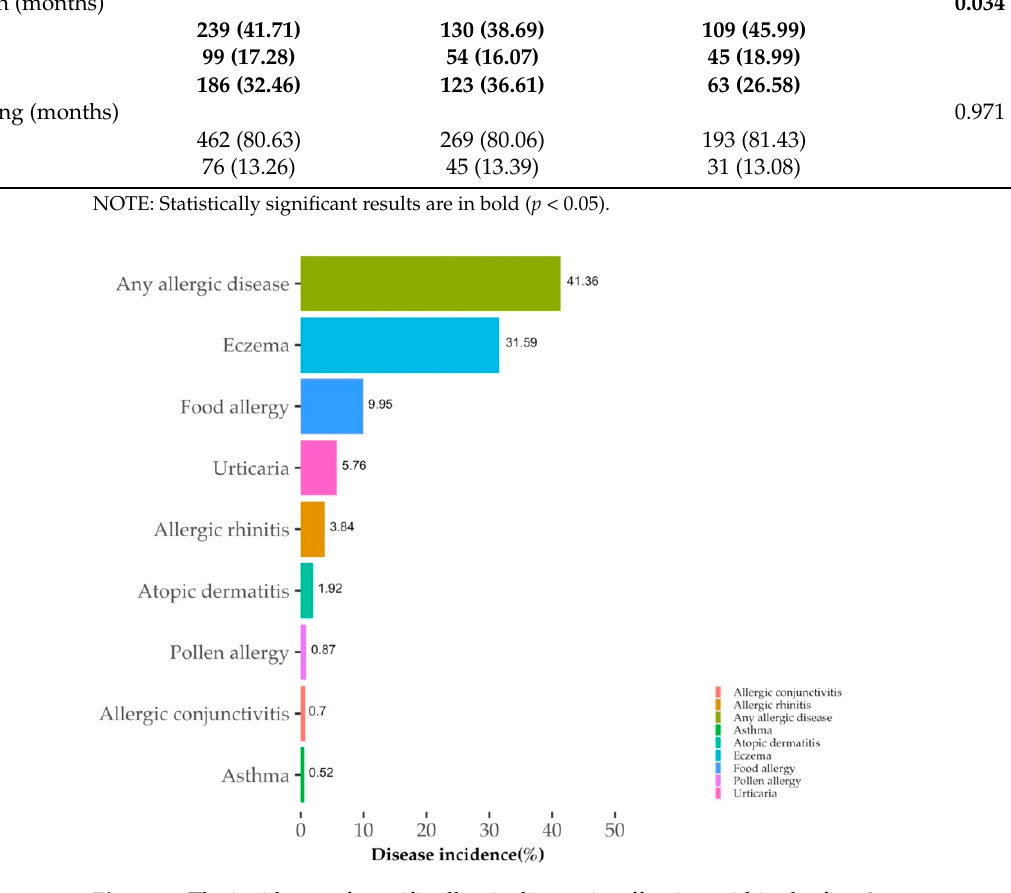
Figure 1. The incidence of specific allergic disease in offspring within the first 2 years.